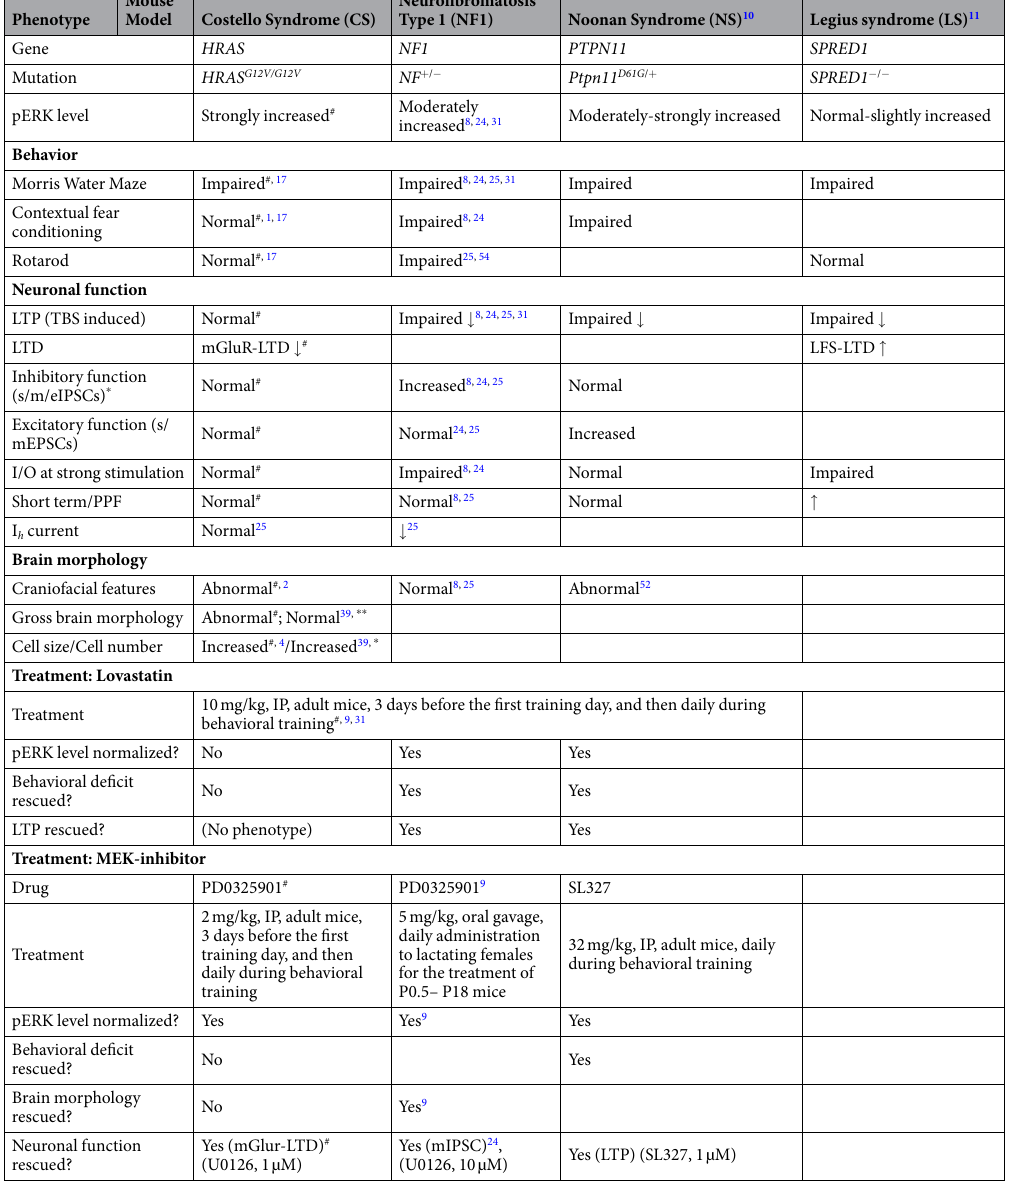
Table 1. Overview and comparison of phenotypes and treatments in mouse models for four different RASopathies. Abbreviations: TBS – theta burst stimulation; LFS - low frequency stimulation, ↑ - significant increase; ↓ - significant decrease; Normal - no difference observed; “ − ” – no rescue observed; “ + ” – rescue observed; LTD – long-term depression; LTP – long-term potentiation; I/O – input/output; pERK – phosphorylated ERK; IP – Intra peritoneal injection; s-, m-, e E/IPSCs – spontaneous-, miniature- or evoked- excitatory (E)/inhibitory (I) postsynaptic currents; * - mIPSCs recordings in high KCl concentration (12,5 mM); ** - young animals, E14-P7; # - current